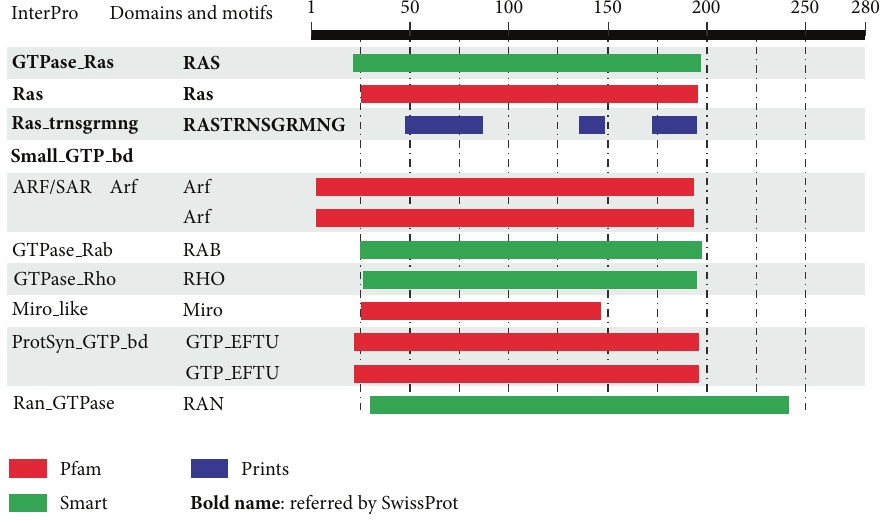
Figure 2: Different proteins that have similar domains like AGS1/RasD1/Dexras1. Dexras1 has been used as a reference protein in this figure and shows amino acids from 1–280. Reference: